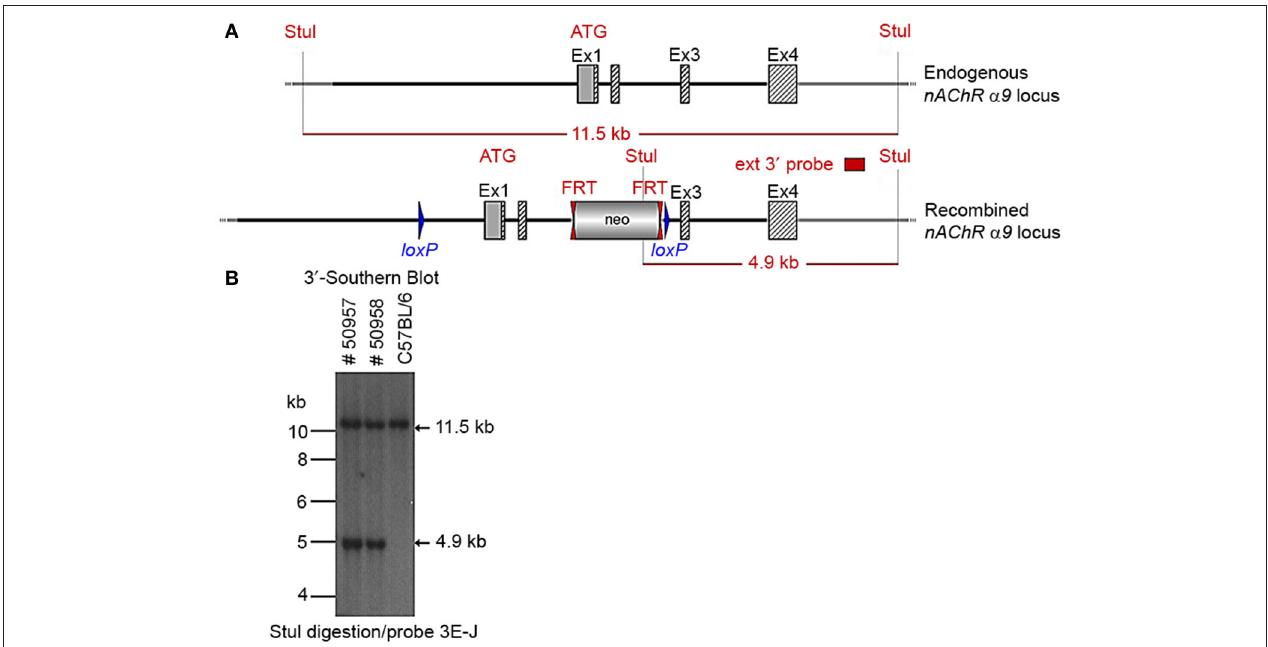
FIGURE 3 | (A) The schemata for the endogenous and recombined α 9 nAChR loci. (B) The Southern blot analysis of the α 9 F1 generation. A 90% chimeric male mouse from clone HA11 was mated with C57BL/6J females. The genomic DNAs of two resulting agouti pups (#50957 and #50958) were compared to C57BL/6J wildtype DNA. StuI digested DNAs were blotted on nylon membrane and hybridized with the external 3 ′ probe (3E-J) to validate the heterozygosity of the nAChR α 9 gene mutation.